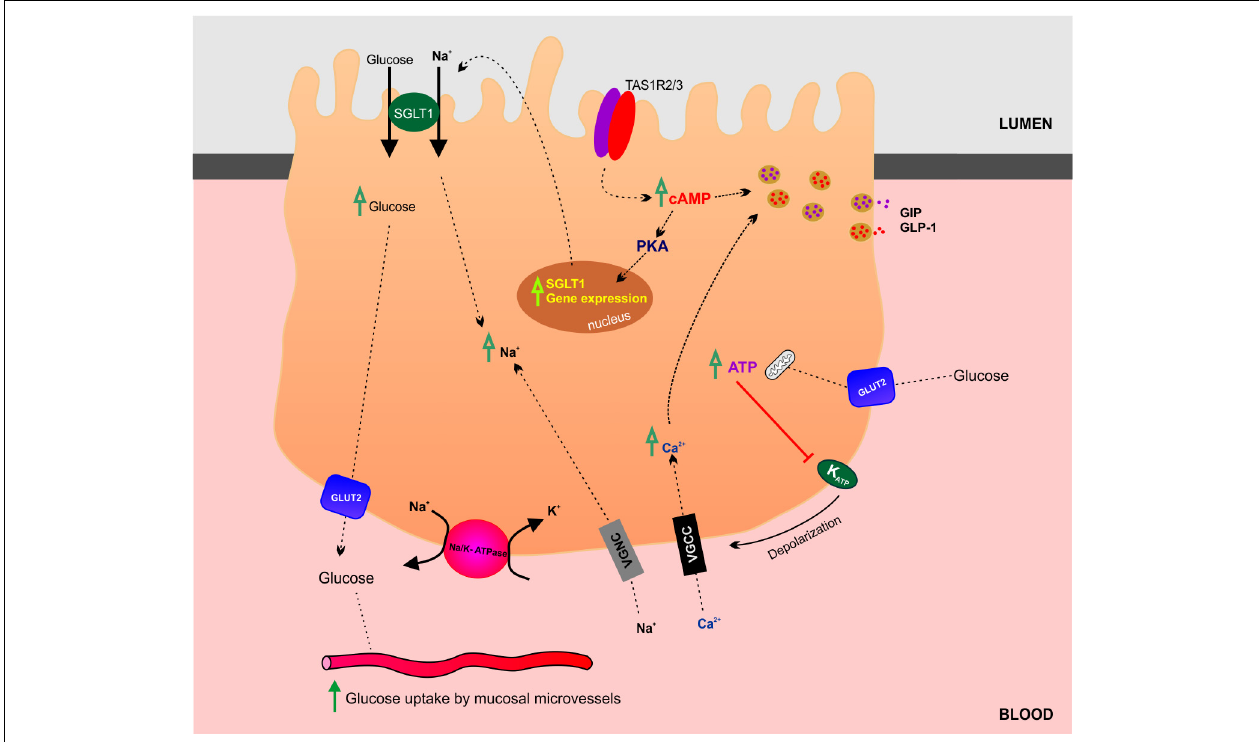
FIGURE 3 | Glucosensing and transport in the gut. This schematic highlights the transport and regulatory mechanisms involved in glucose absorption by enterocytes in the small intestine.